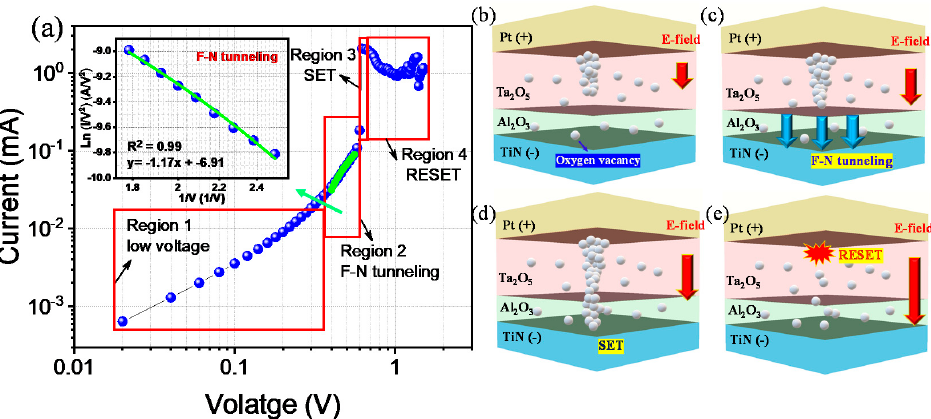
Figure 6. ( a ) Independent four regions of Pt/Ta 2 O 5 /Al 2 O 3 (3 nm)/TiN device by differentiating the conduction process. (Inset shows the fitting result of Fowler–Nordheim (F–N) tunneling to evaluate the linearity in the fitting region). Conducting path evolution of Pt/Ta 2 O 5 /Al 2 O 3 (3 nm)/TiN device in the positive bias. ( b ) high-resistance state (HRS); ( c ) FN tunneling in region 2; ( d ) LRS in region 3; ( e ) reset process in region 4.